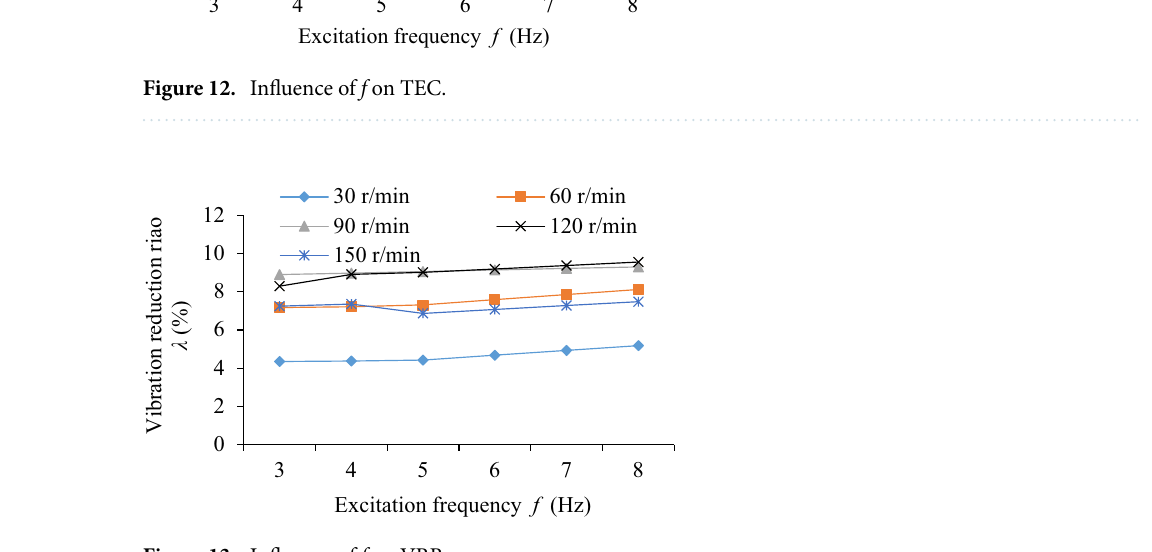
Figure 13. Influence of f on